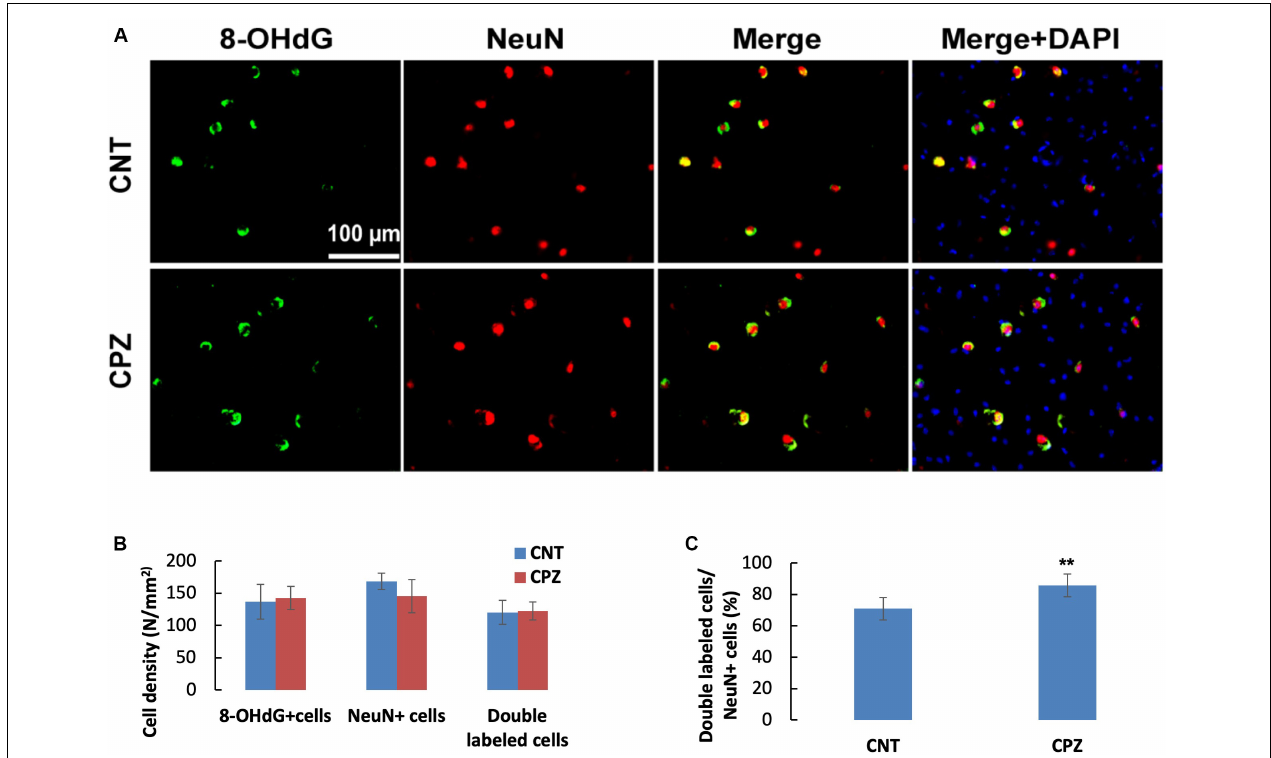
FIGURE 6 | (A) Representative photographs showing cells labeled by the antibody to 8-OHdG, antibody to NeuN, and double labeled cells by the two antibodies. (B,C) Bar charts showing the statistical analysis results of the immunofluorescent staining. Data are expressed as means ( SD (n ( 6/group). ** p < 0.01. The comparisons were made between CNT and CPZ groups by performing t -test or chi-square test (percentage of double labeled cells in NeuNi +